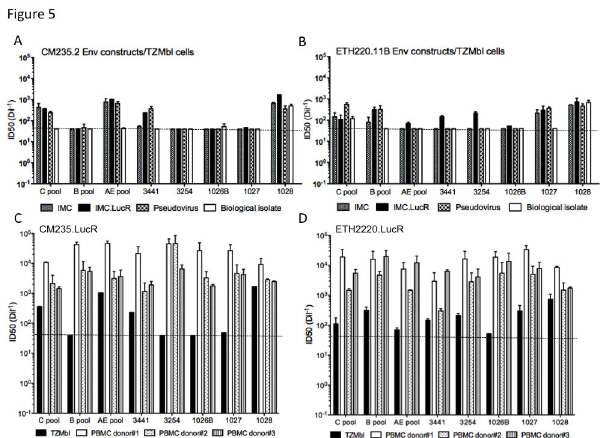
Figure 5. Neutralization profiles CM235.2 and ETH2220.11B Env-based viruses. Inhibition of infection using HIV-1+ sera and multiple viral forms (pseudovirus, biological isolate, original IMC and IMC.LucR) of CM235.2 (A) and ETH2220.11B (B) in the TZM- bl assay, using the cell-line encoded firefly luciferase reporter endpoint. Inhibition of infection using HIV-1+ sera and CM235.LucR (C) and ETH2220.LucR (D) in the TZM-bl and PBMC assay with three different donor PBMC as assay targets, using the IMC- encoded Renilla luciferase reporter endpoint. Values are the reciprocal sera dilution at which RLU was reduced by 50% compared to the level in virus control wells. Horizontal lines represent the threshold of detection (1:40 sera dilution); values at or under the line indicate 50% inhibition was not reached.